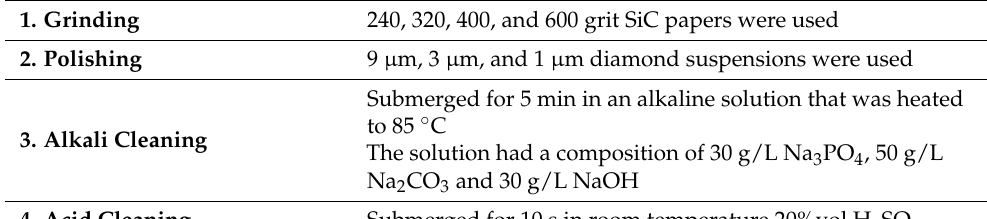
Table 2. Substrate